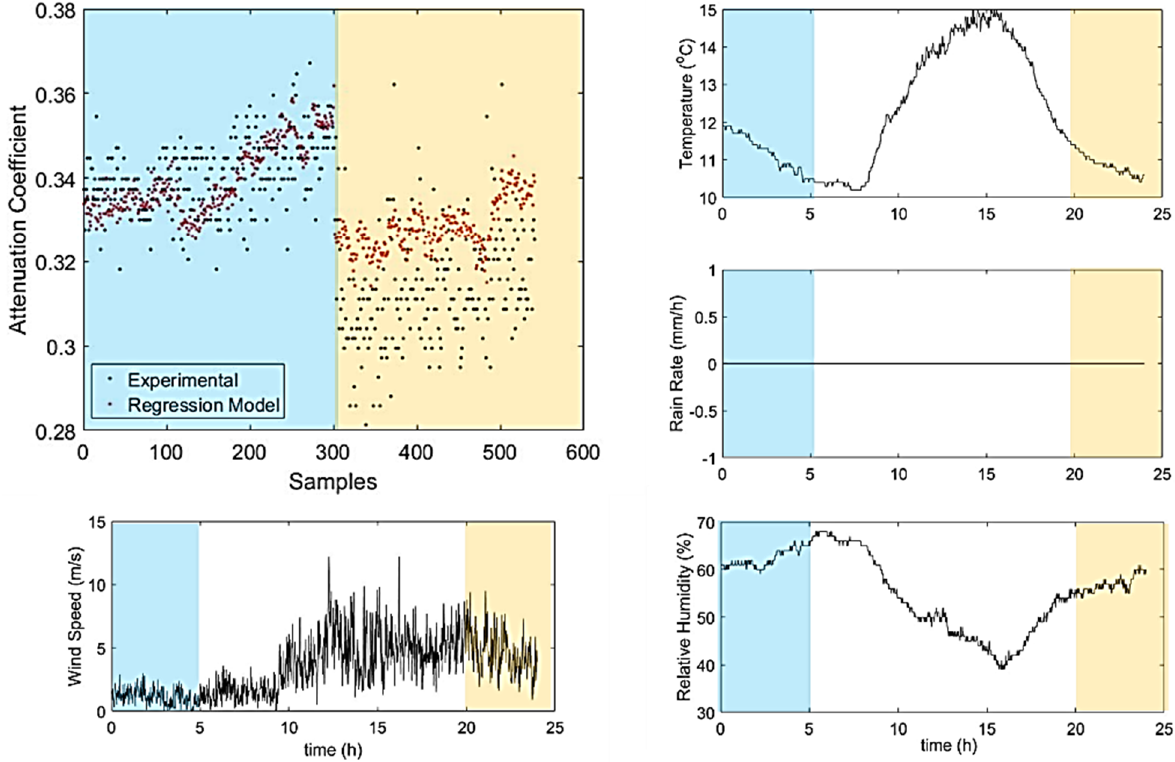
Figure 6. Experimental measurements and model predictions, i.e., Equation (6), for 16 February 2020.